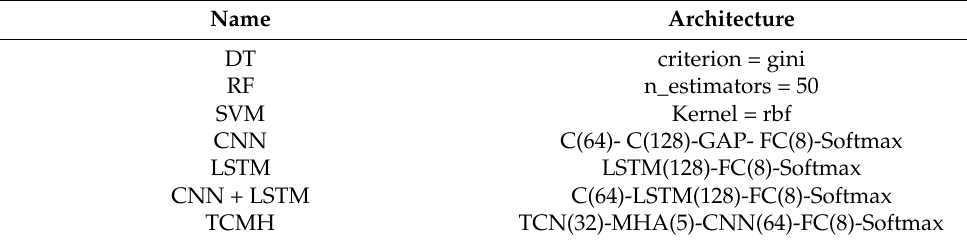
Table 2. Detailed parameters of the baseline